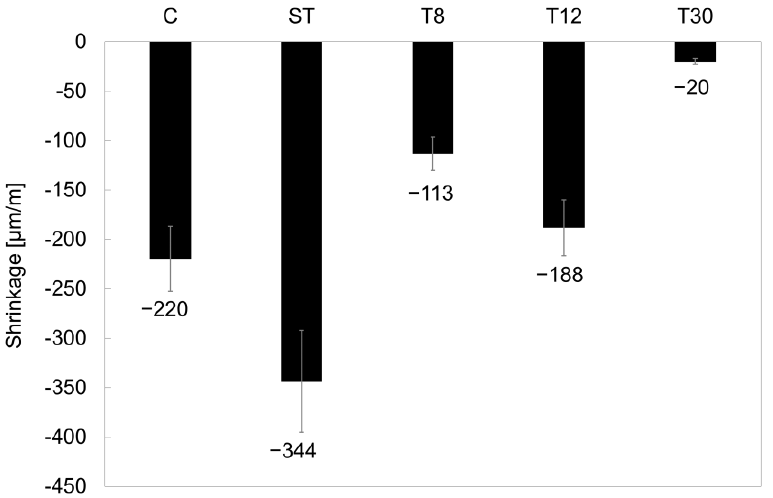
Figure 4. Shrinkage of mortar samples at 28 days of curing. The error bars represent the standard deviation.